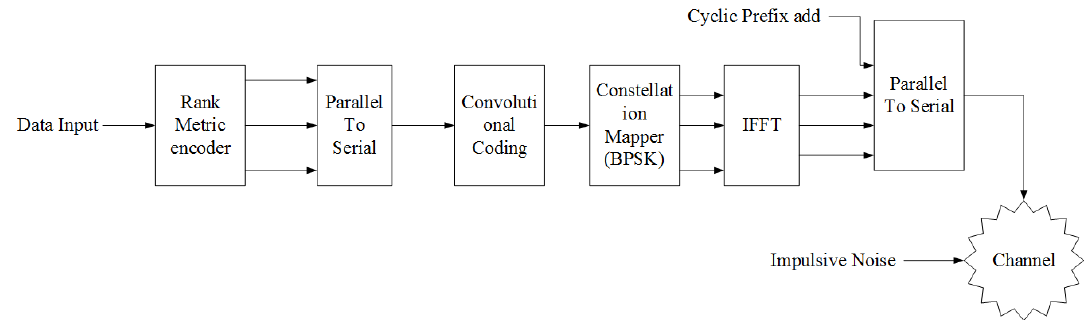
Figure 1. The physical layer